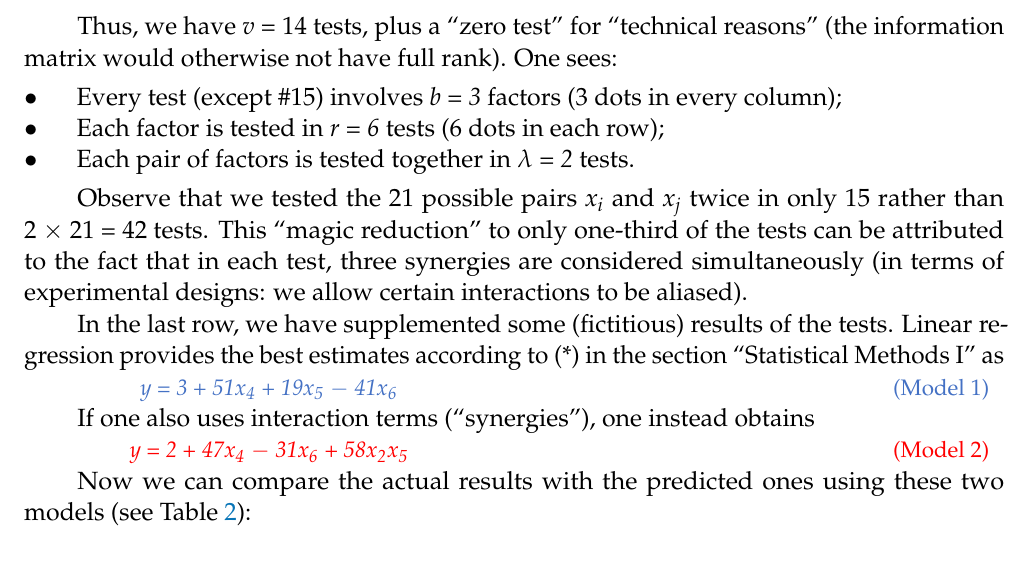
Table 2. Comparing two test results with reality.